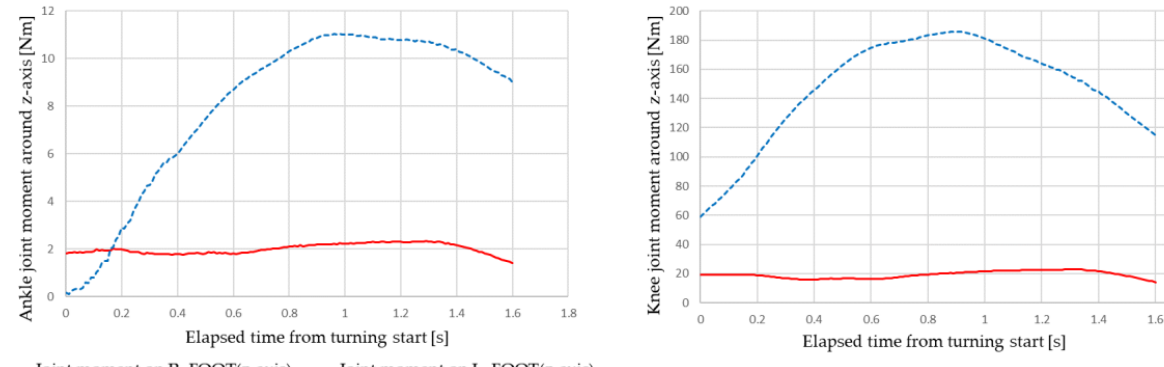
Figure 22. Ankle and knee joint moments during automatic turning.